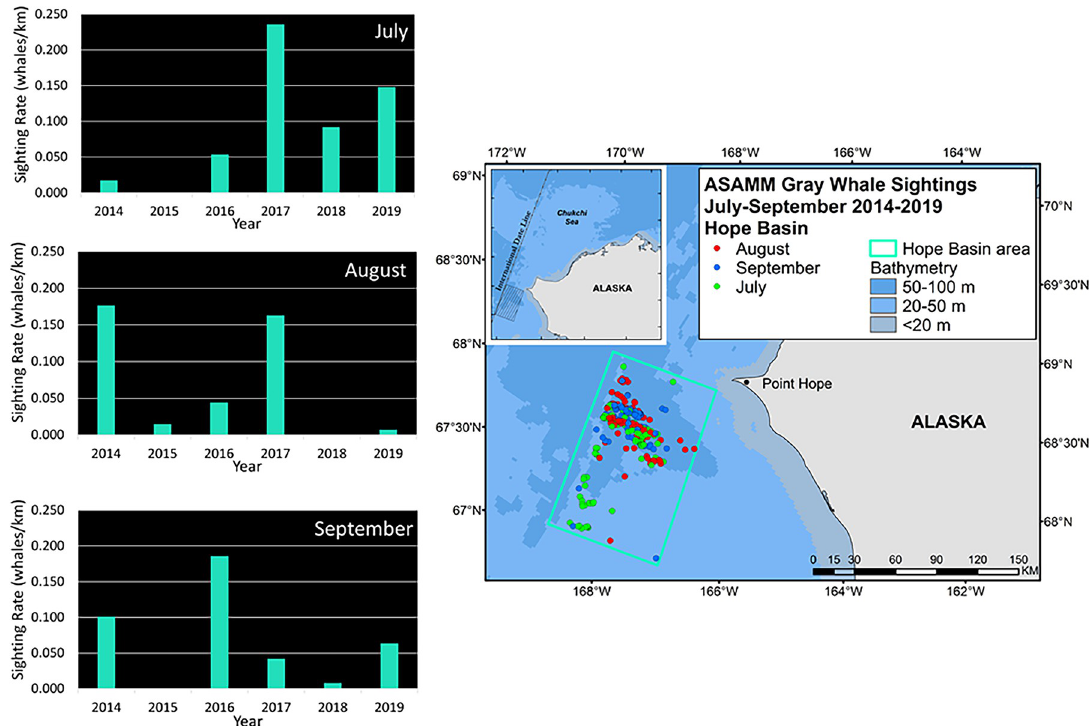
Fig 10. Interannual variability in gray whale monthly distribution and Sighting Rates (SR) for the Hope Basin area in the southern Chukchi Sea, 2014–2019. Inset map shows the location of the Hope Basin area relative to the ASAMM study area. ASAMM data are publicly available at fisheries.noaa.gov/resource/data/1979-2019-aerial-surveys-arctic-marine-mammals-historical-database. Databases used for maps include versions 2012_2014_v0_28, 2015_2017_v22, and